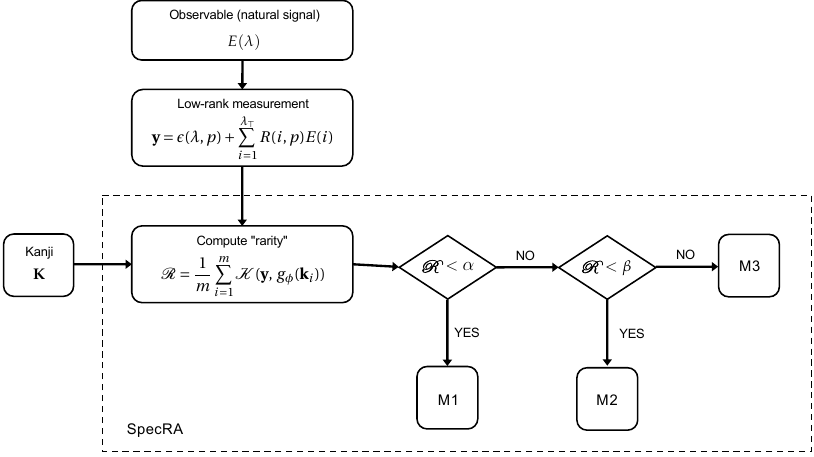
relative to a Kanji K R